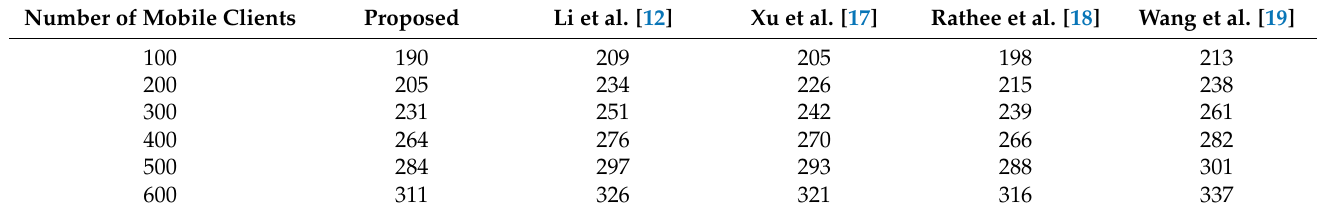
Table 6. Comparison on average login authentication delay.